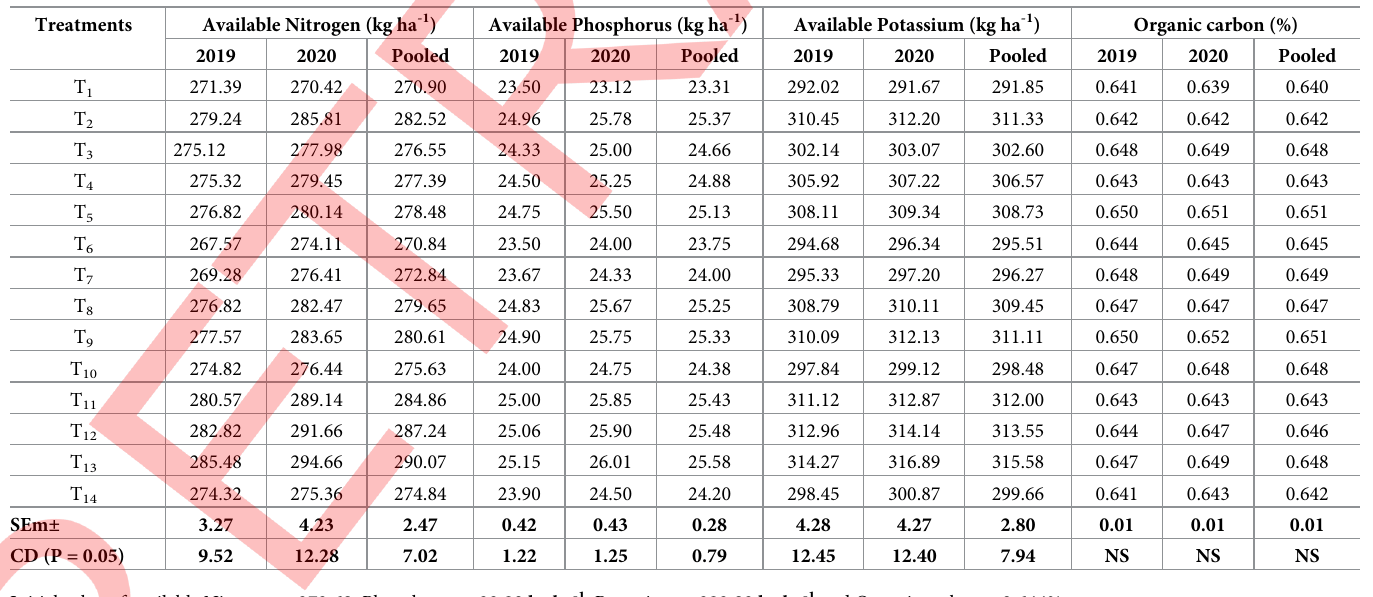
Table 1. Effect of organic manures on available nutritional content (kg ha -1 ) in soil.